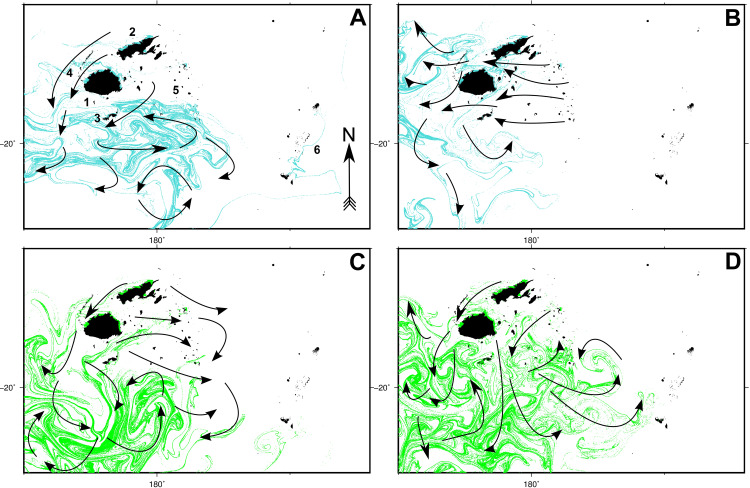
Particle dispersal simulation results for 2012 and 2013 datasets (non-ENSO years).Final (day 60) particle position plots are shown for spawning seasons 1 (A) and 2 (B) for 2012, and seasons 1 (C) and 2 (D) for 2013. All simulations were run for 60 days. Arrows denote the positions and trajectories of major particle flux patterns. Animations of these simulations are available as S1–S4 Gifs. Numbers denote the following localities: Viti Levu (1), Vanua Levu (2), Kadavu (3), Yasawa archipelago (4), Lau archipelago (5) and the Kingdom of Tonga (6).